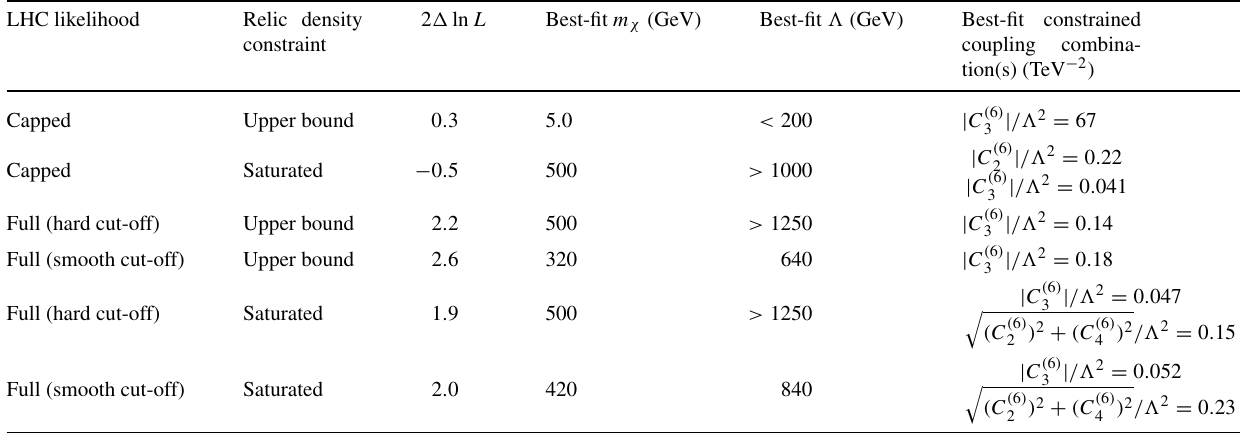
we only quote the combination that is well-constrained rather than each parameter individually. Parameters not stated explicitly are compatible with